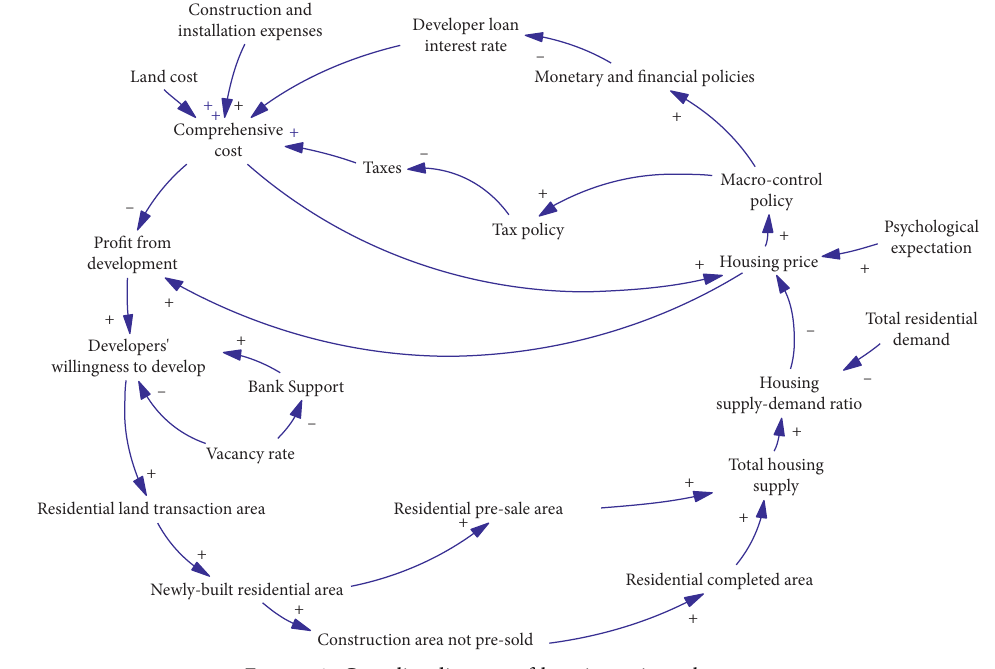
Figure 3: Causality diagram of housing price subsystem.